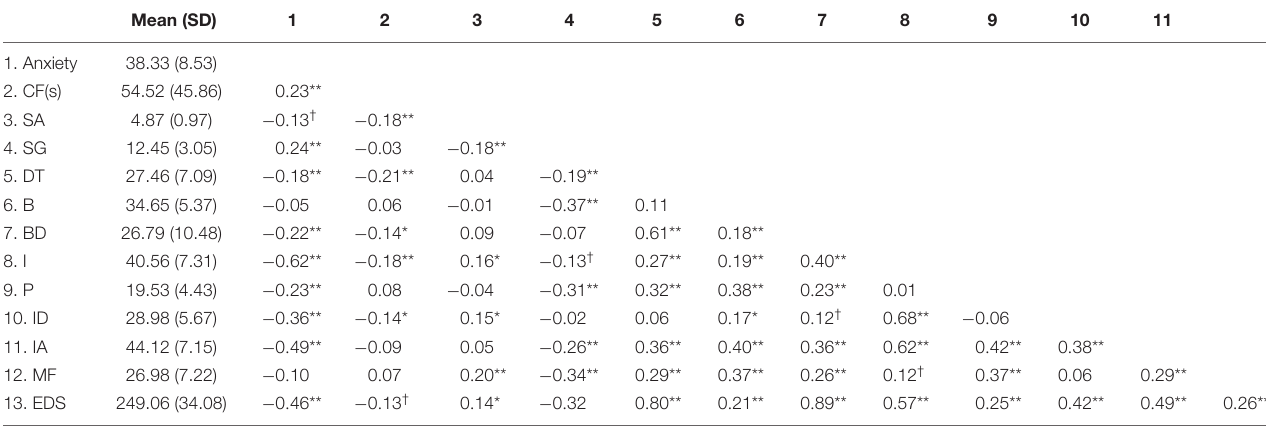
TABLE 1 | Partial correlations for anxiety, cognitive flexibility, sustained attention, social gain, and eating disorder symptoms after controlling for age. Mean (SD)